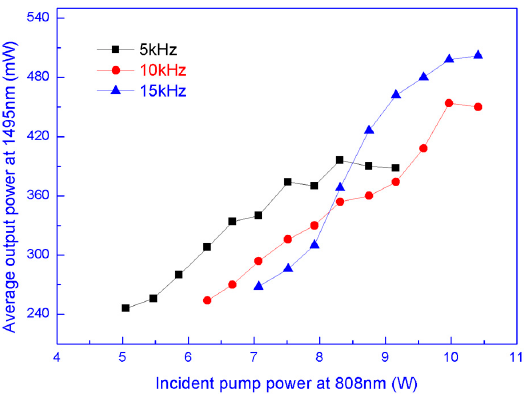
Figure 4. Average output power of 1495 nm laser with respect to the incident pump power for the PRRs of 5 kHz, 10 kHz, and 15 kHz.